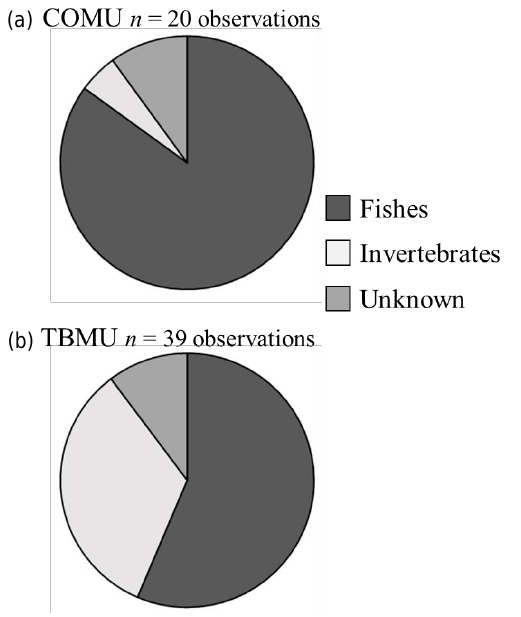
Figure 4. Diet composition of (a) common murres (COMU) and (b) thick-billed murres (TBMU) based on direct observations of prey delivered to